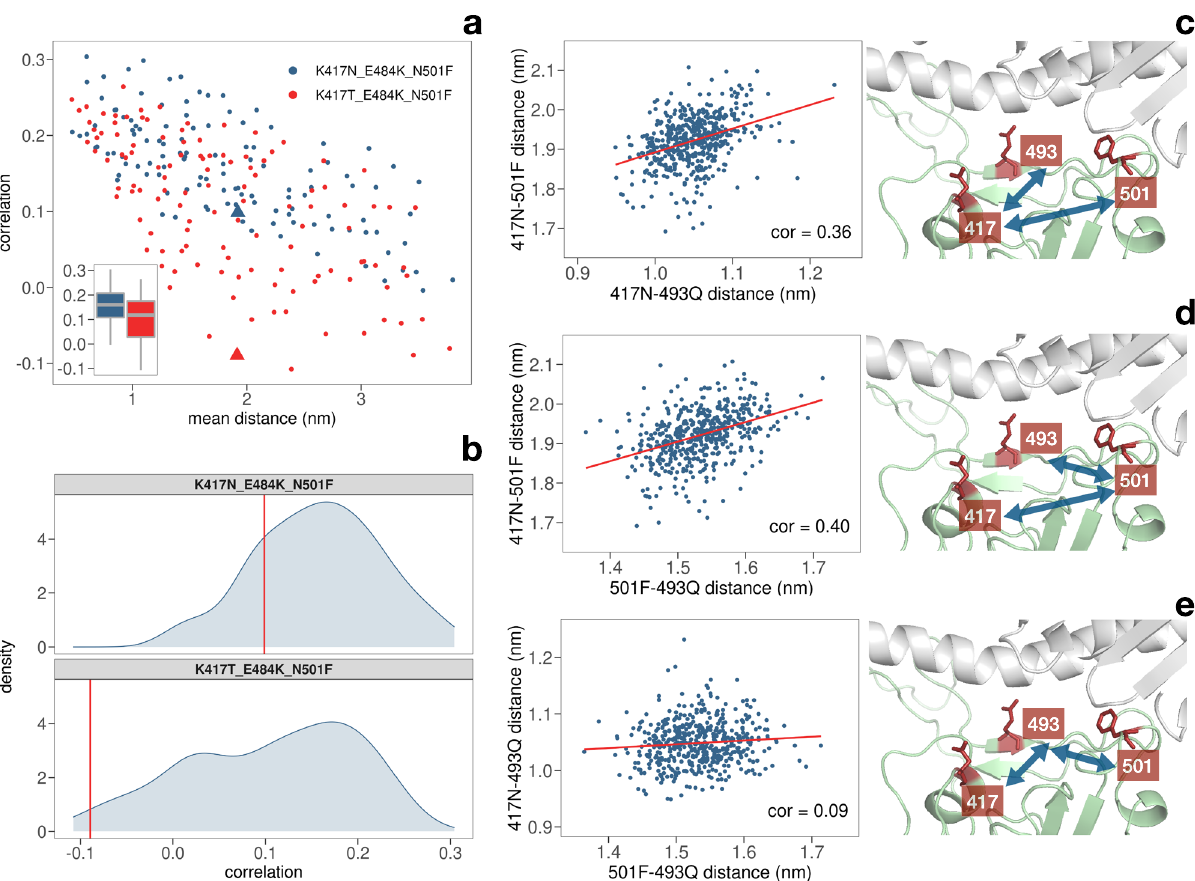
Fig. 7 Analysis on the residues ’ motion in variants carrying the 501F mutation. a Spatial correlation of the motion of all possible couples of residues of the spike protein as a function of their average spatial distance (of the residue centroids) during the simulation. Blue dots correspond to the residues of the South African variant with the putative N501F additional mutation with red dots represent all the couples of residues of the Amazonian variant with the N501F mutation. Box plots of the correlations are shown in the inset. b Distribution of the correlations in the motion of all the couples of residues having a sequence distance higher than three residues. Red vertical lines mark the correlation of residues 417 – 501. c Distance between the centroids of residues 417 – 501 vs resides 417 – 493 during the molecular dynamics simulation of the South African variant with the putative N501F additional mutation. Cartoon representation of the binding region between spike (green) and ACE2 receptor (gray), highlighting in red the key residues 417, 493, and 501. d Same as in ( c ) but for couples 417 – 501 vs 493 – 501. e Same as in ( c ) but for couples 417 – 493 vs 493 –